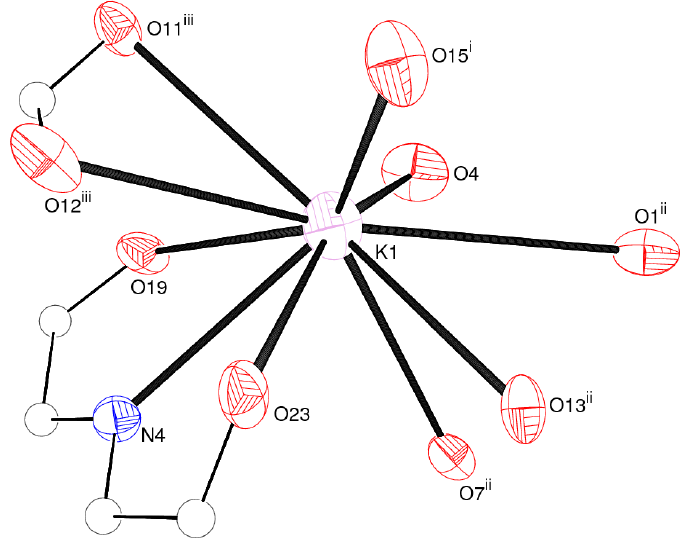
Figure 3. Detail of 1 (50% displacement ellipsoids, arbitrary spheres for the C atoms) showing the potassium-ion coordination. Symmetry codes as in Table